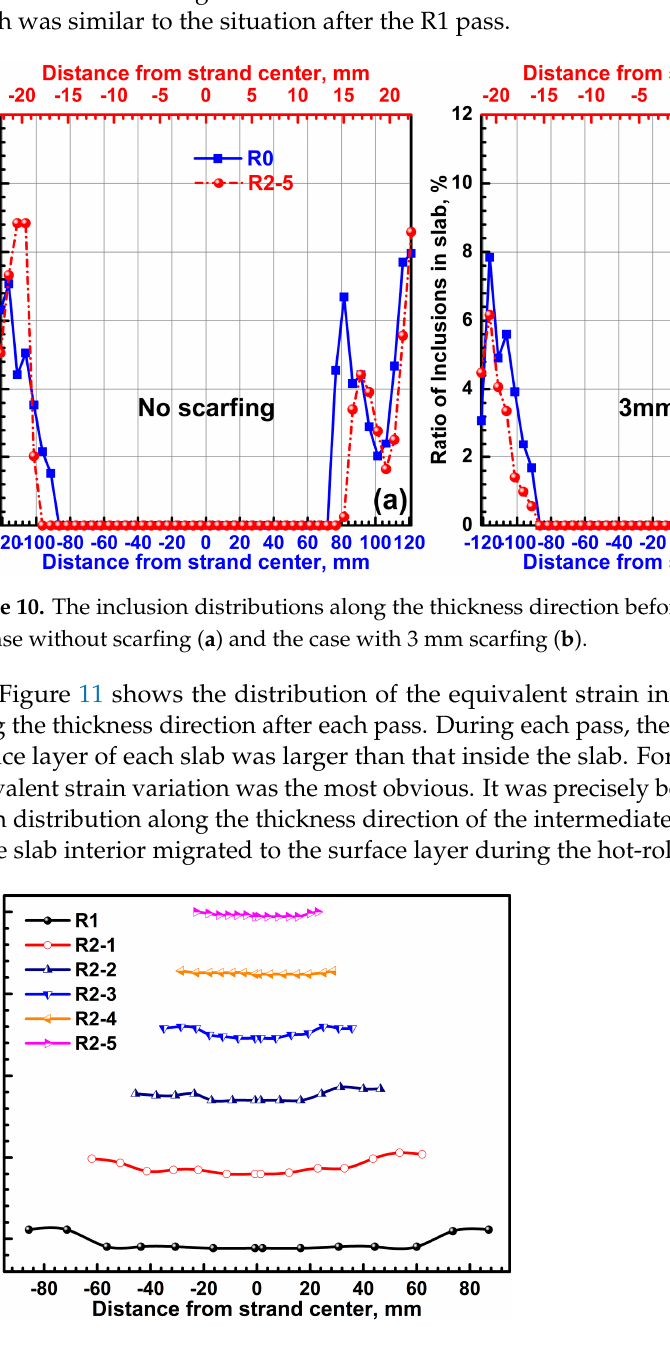
Figure 11. Variations in equivalent strain in the intermediate slab along the thickness direction.